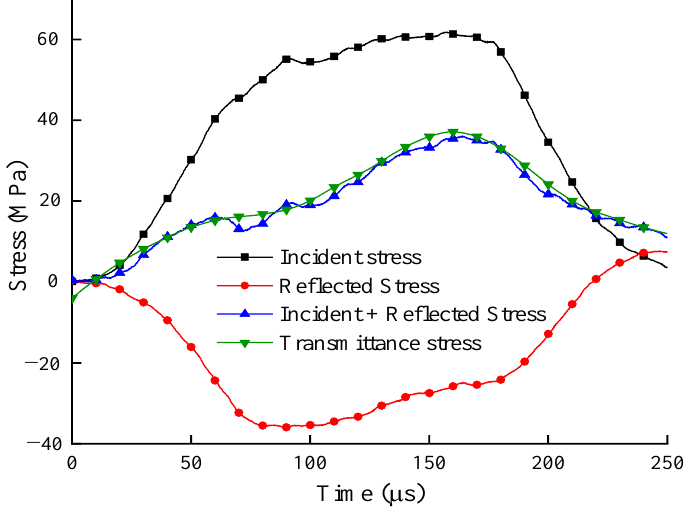
Figure 2. The schematic diagram of SHPB.